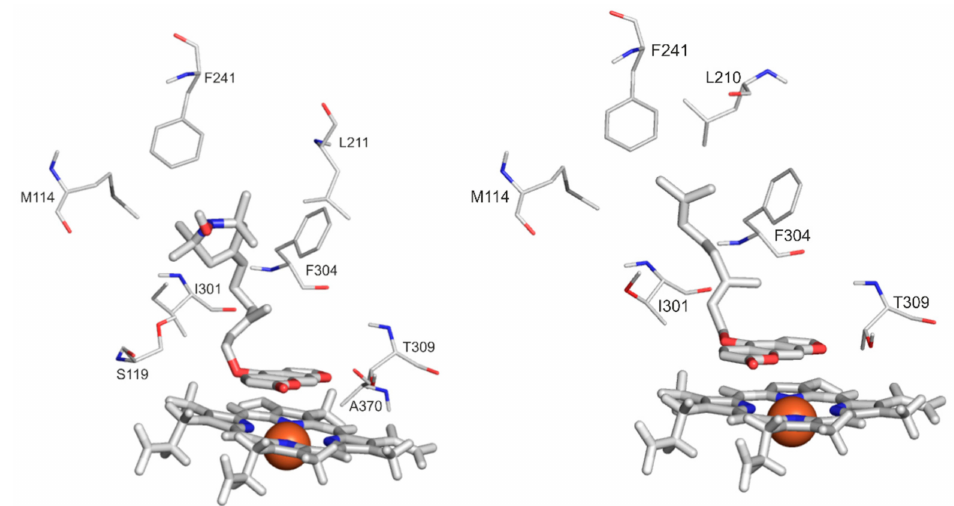
Figure 5. The close-up of the binding mode of SL-BM (left) and BM (right) (wide sticks) as docked to the binding pocket of the CYP3A4 enzyme above the heme ring (wide sticks) where iron is represented as an orange sphere. Interacting enzyme residues are labelled and shown as thin sticks.